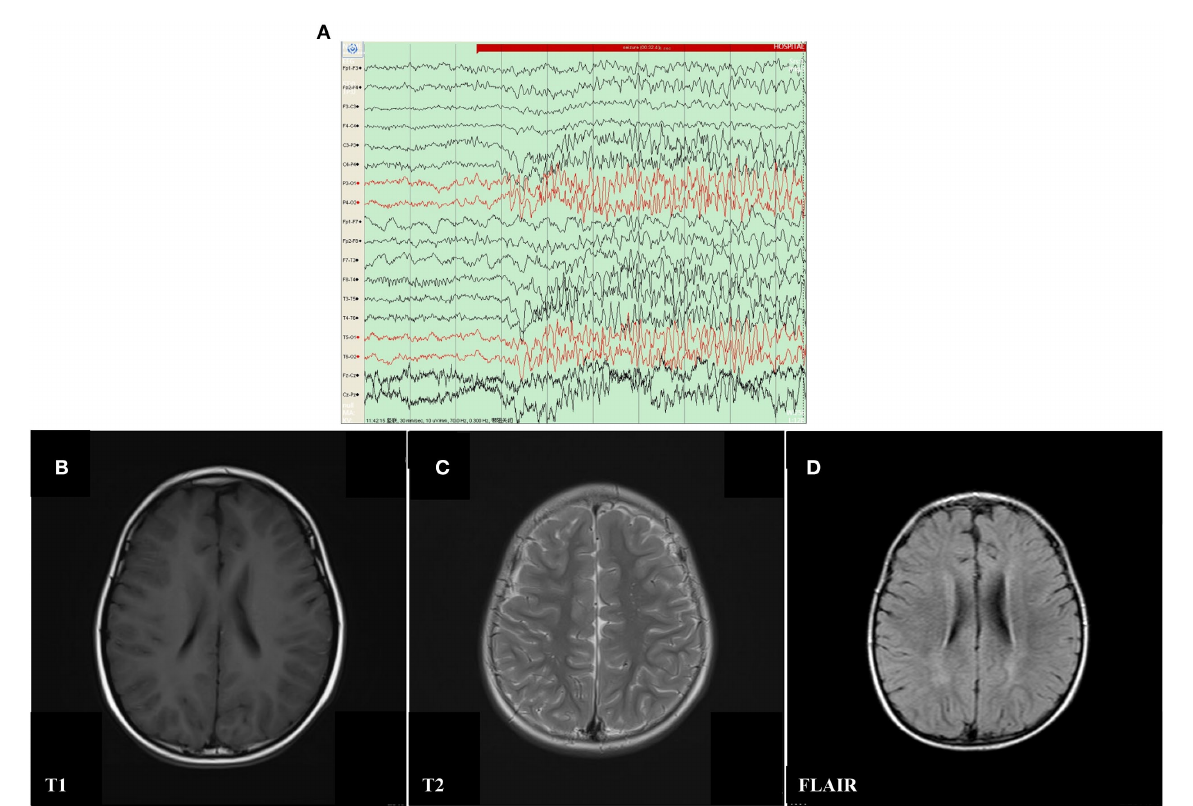
FIGURE1 Electroencephalography (EEG) and Cranial magnetic resonance imaging (MRI) result of proband with mosaic mutation in PCDH19 gene (c.840C > A, p. Tyr280*). (A) The analysis of electroencephalography (EEG) exhibited that sharp waves and sharp slow complex waves in the bilateral parietal, occipital, and posterior temporal regions were distributed locally with normal background during the interictal period. (B–D) Punctate white matter lesions appeared with slightly long T1 and T2 signals, as well as slightly high signal on FLAIR in the periventricular white matter and slightly plump bilateral